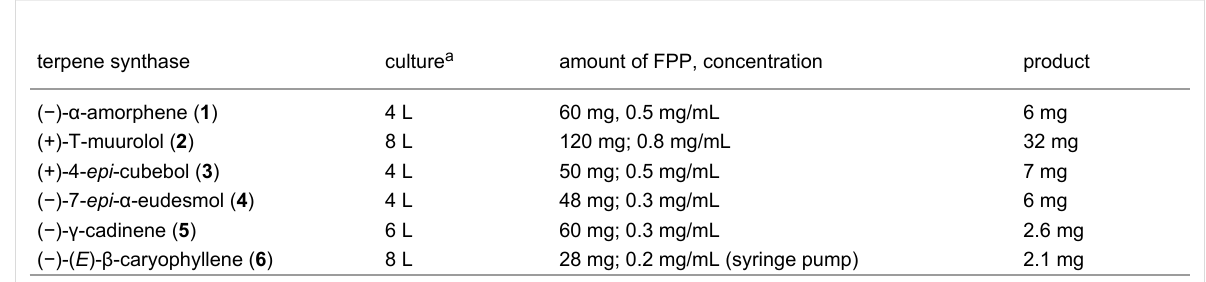
Table 4: Yields from enzyme incubation